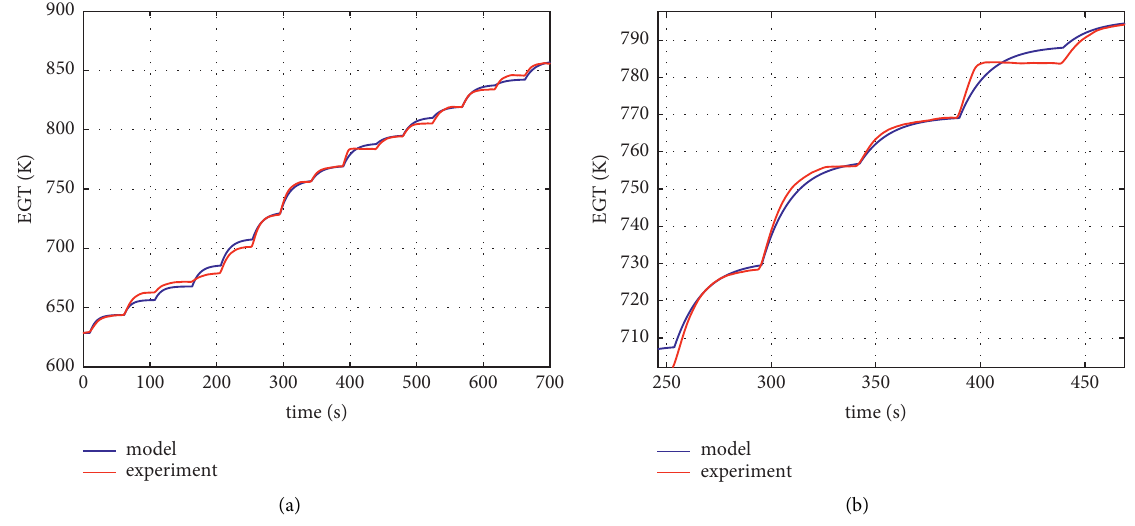
Figure 16: EGT simulation results. (a) EGT results in loading process. (b) EGT results during 250s to 450s.